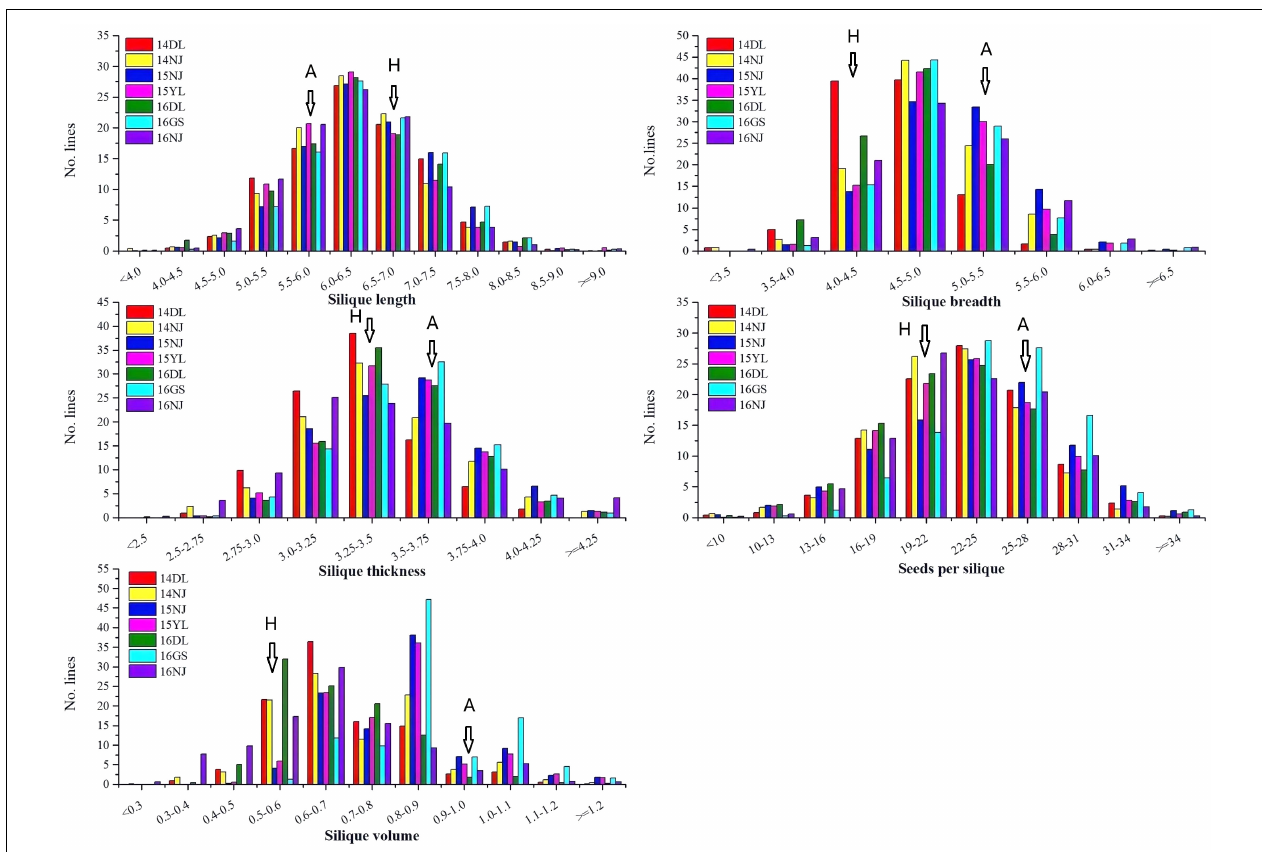
FIGURE 1 | Phenotype frequency distributions of five silique-related traits in the AH population. 14DL, 14NJ, 15NJ, 15YL, 16DL, 16GS, and 16NJ are the codes for the following different years and environments: 2014 Dali, 2014 Nanjing, 2015 Nanjing, 2015 Yangling, 2016 Dali, 2016 Gansu, and 2016 Nanjing, respectively. A represents the female parent “APL01” and H represents the male parent “Holly” of the AH population.